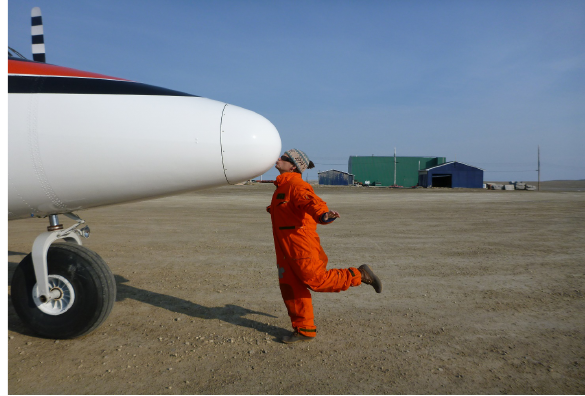
Figure 8. Maybe this will help… (Photo: D. G.